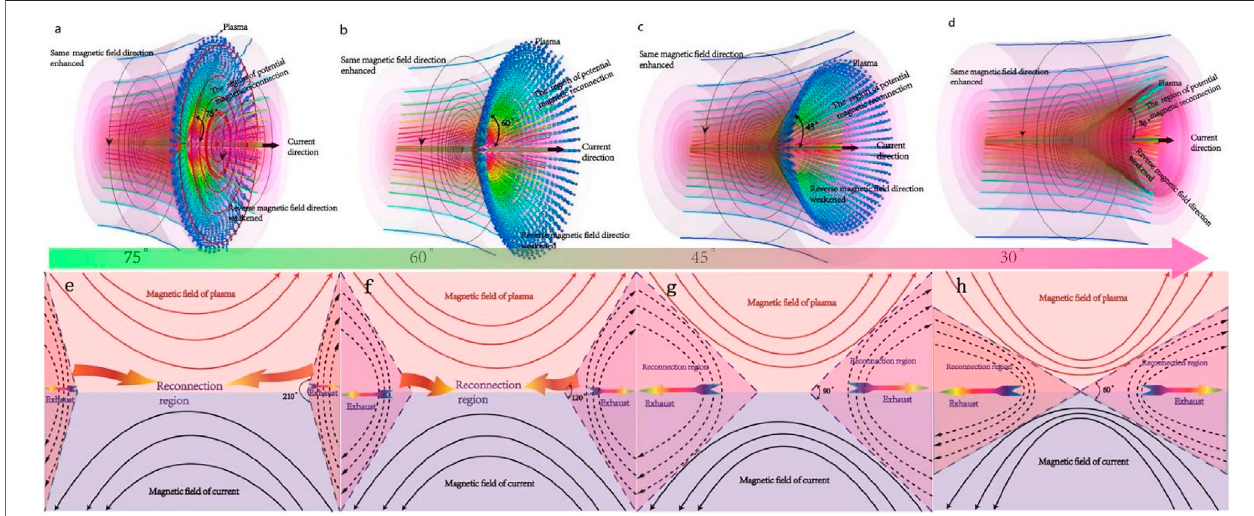
FIGURE 6 | The evolution of magnetic fi eld topology with plasma motion. (A – D) Three-dimensional magnetic fi eld topological map, the angle between the moving plasma, and the axis of 75 ° , 60 ° , 45 ° , and 30 ° , corresponding to Panels (A – D) , respectively. (E – H) Distribution of the magnetic lines of force on the slice plane of the inverted magnetic fi eld region, which is parallel to the direction of plasma motion. In addition, Panels (E – H) correspond to Panels (A – D) respectively.